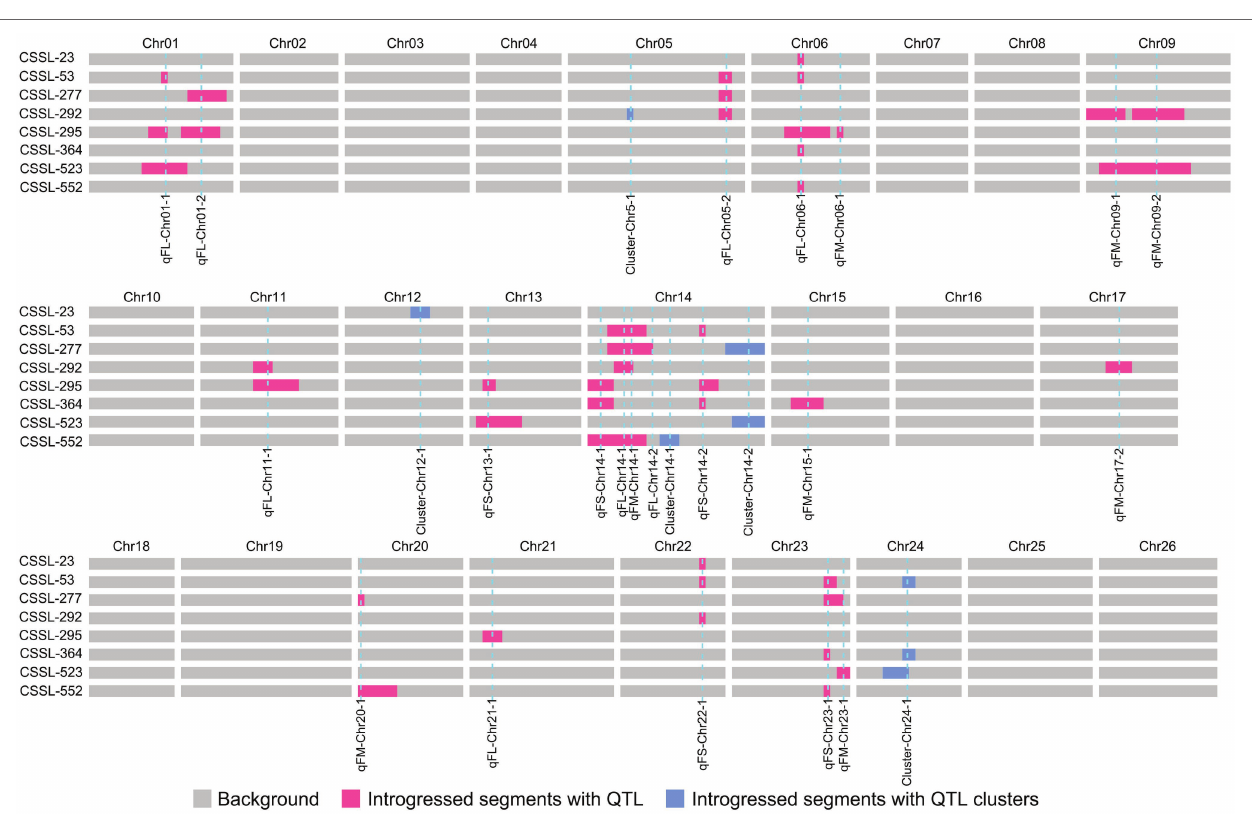
FIGURE 4 | Distribution of chromosome introgressed segments for excellent